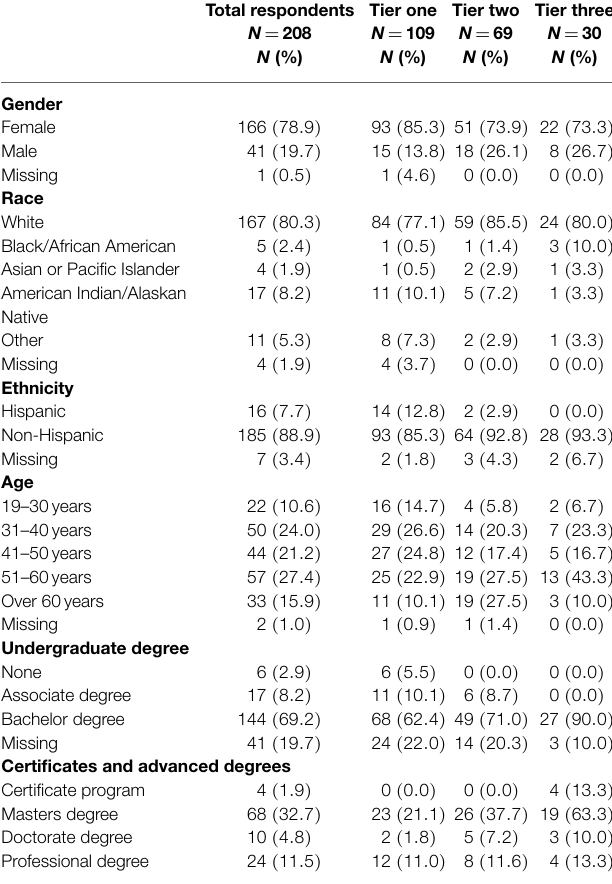
TABLE 1 | Demographic characteristics of respondents